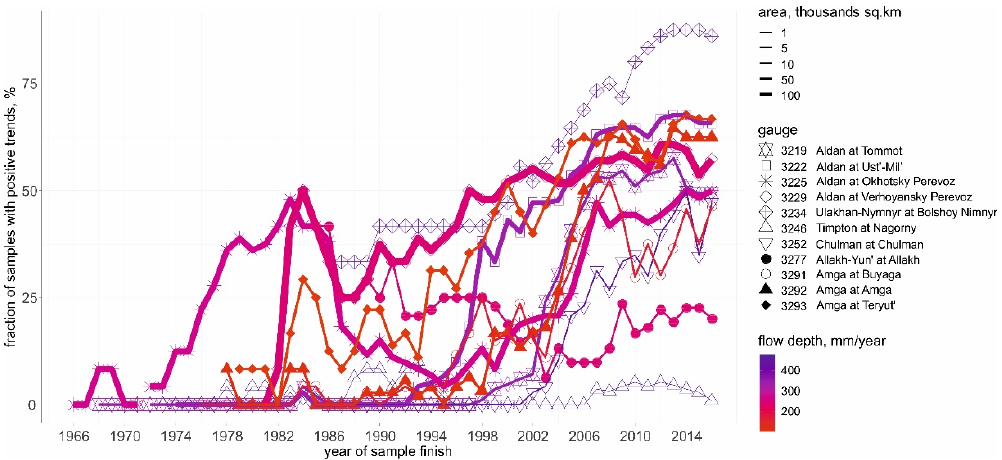
Figure 5. Fraction of samples with positive trends at the studied gauges for different ending years.